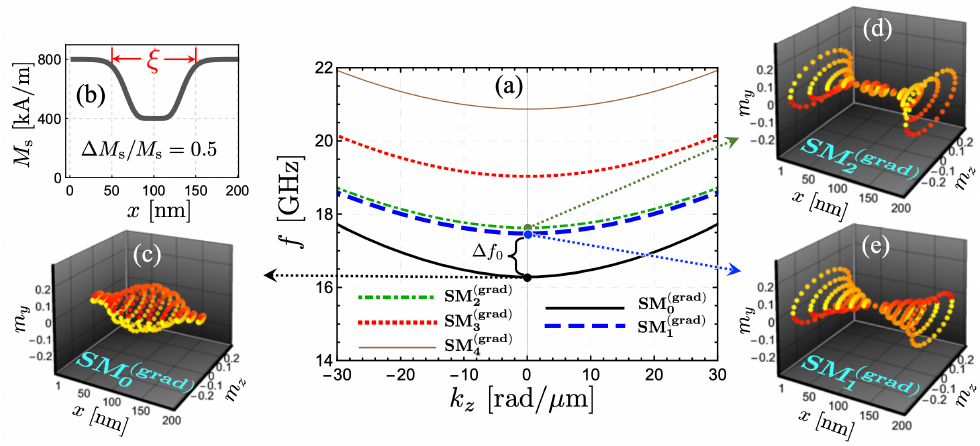
Figure 3. ( a ) Spin-wave dispersion of a magnetization-graded strip. The magnetic profile is shown in ( b ), where a notable reduction of M s along the width is assumed ( ∆ M s / M s = 0.5) and ξ = 100 nm. ( c ), ( d ) and ( e ) depict the SW orbits along the strip width for modes SM respectively. The dynamic magnetization components m z and m y are calculated with arbitrary